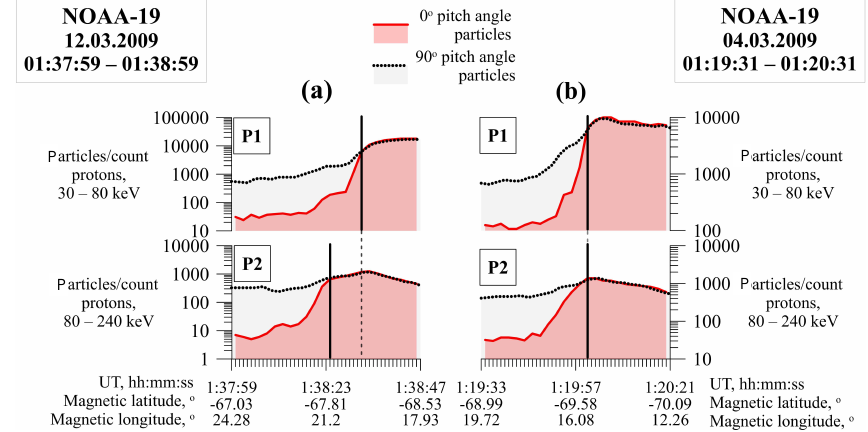
Figure 1. Count rates of trapped ( J 90 , black dotted line) and precipitating ( J 0 , red line) energetic ion fluxes provided by NOAA-19 in premidnight sector. Isotropy boundaries are marked by vertical lines. Event (a) corresponds to the standard energy dispersion and event (b) to the “no IB dispersion”